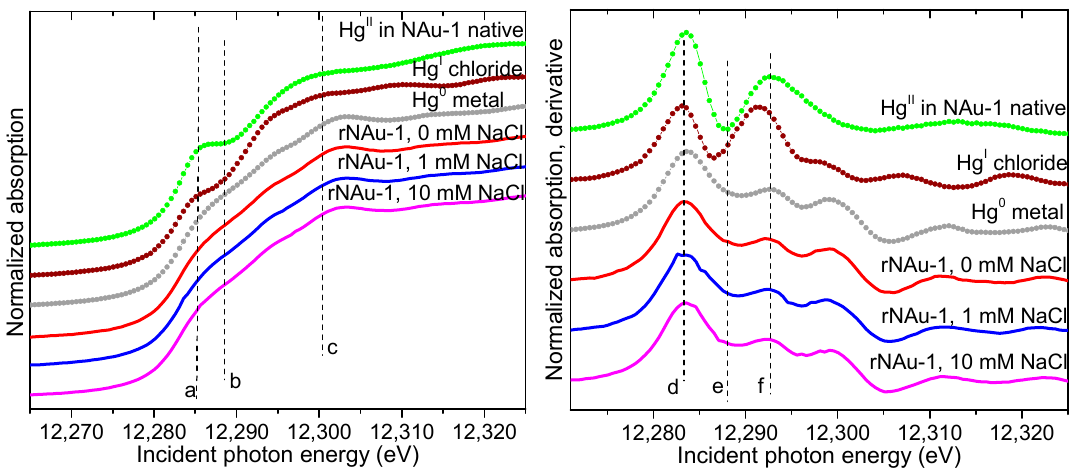
Figure 5. Hg L III -edge XANES spectra ( left ) and derivative ( right ) from the solids in the rNAu-1 systems with increasing NaCl concentrations compared to standards (symbols). The vertical dashed lines (a–f) are a guide to the eye, delineating features corresponding to the di ff erent valences of Hg.